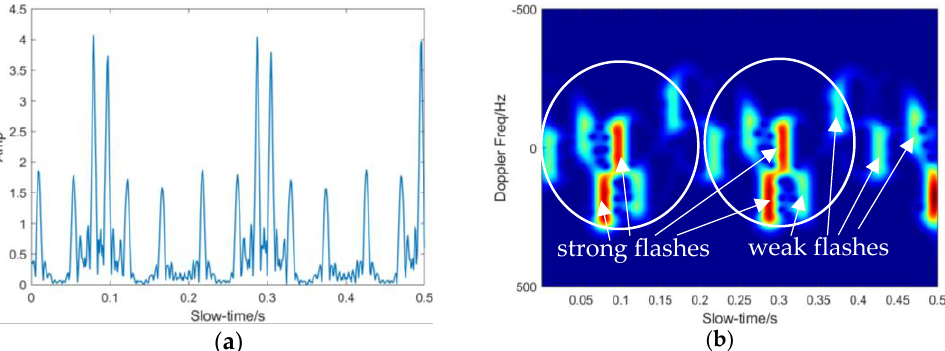
Figure 18. The simulated PO echoes: ( a ) the range profile of the PO echoes; ( b ) the TFD of the original echoes.